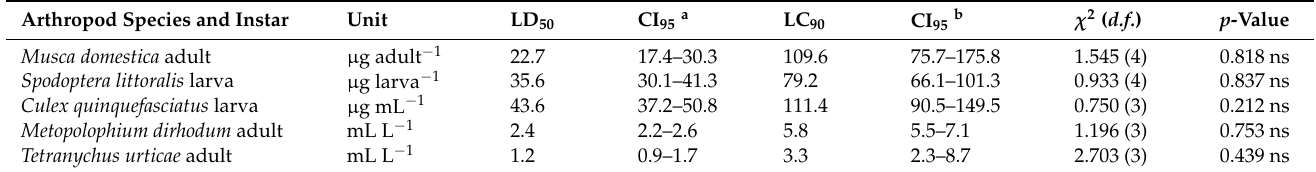
Table 2. Acute toxicity of the Myrothamnus moschatus essential oil on selected insect and mite species. Arthropod Species and Instar